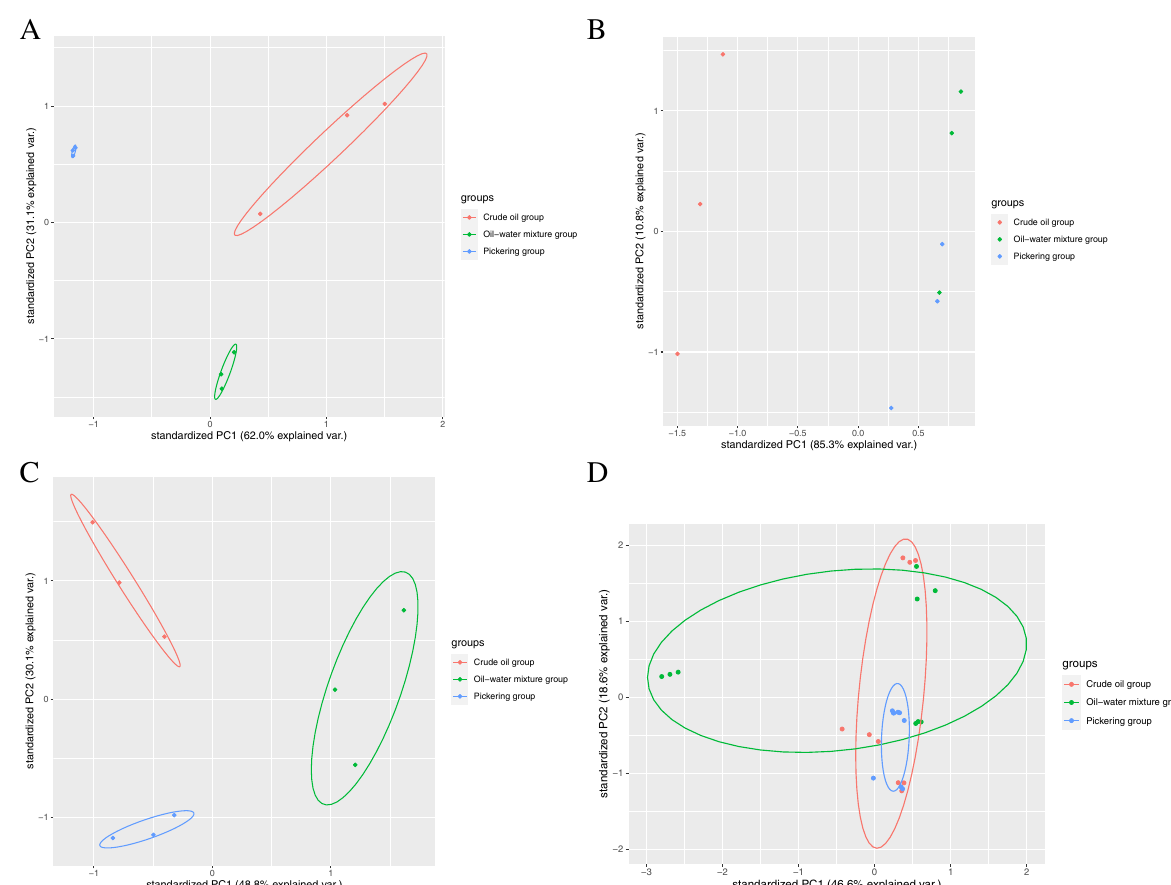
Fig. 5 The total ion current zmap, the volcano map for each pH segment, and the heat map of the different components of the volatile oil of Acorus